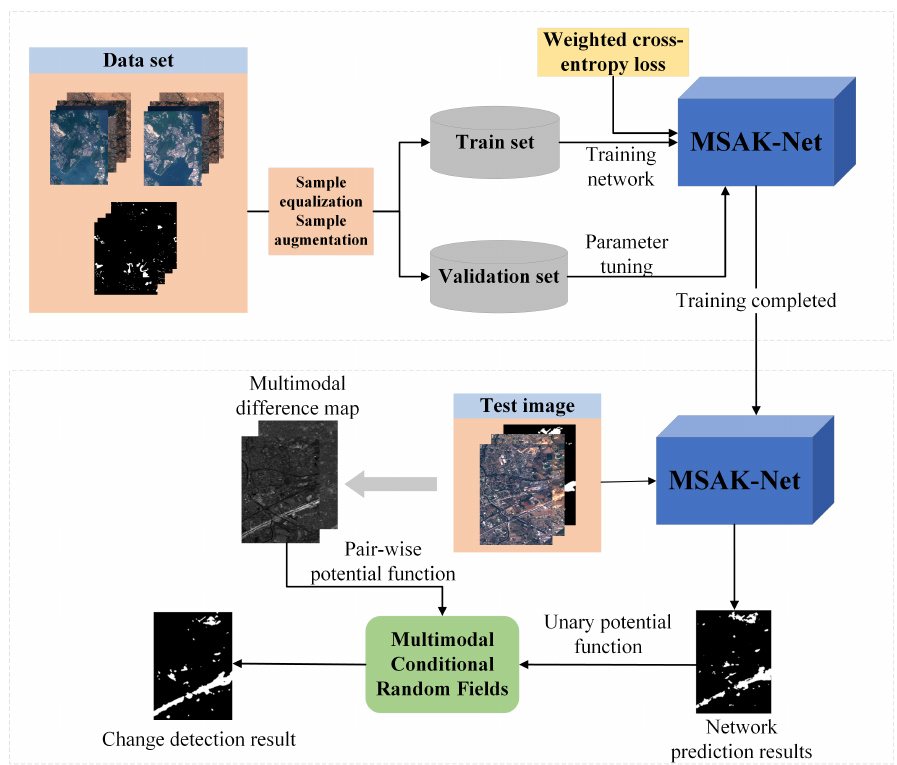
Figure 1. The pipeline of the change detection